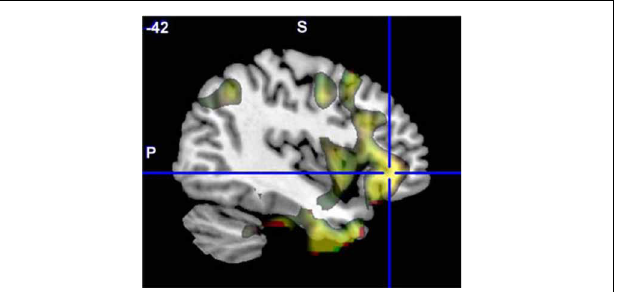
FIGURE 4 | The original ALFF mega-analysis Cohen’s d image for SZ > HC (in red) and the meta-analysis weighted Cohen’s d image (in green) overlaid on a template brain. Both analyses are thresholded at d = 0 . 3 (moderate effect size); areas in yellow indicate both analyses passed the threshold. The cross hair is at ( − 42, 36, − 3), the area of maximal significance in the original ALFF mega-analysis for SZ > HC.